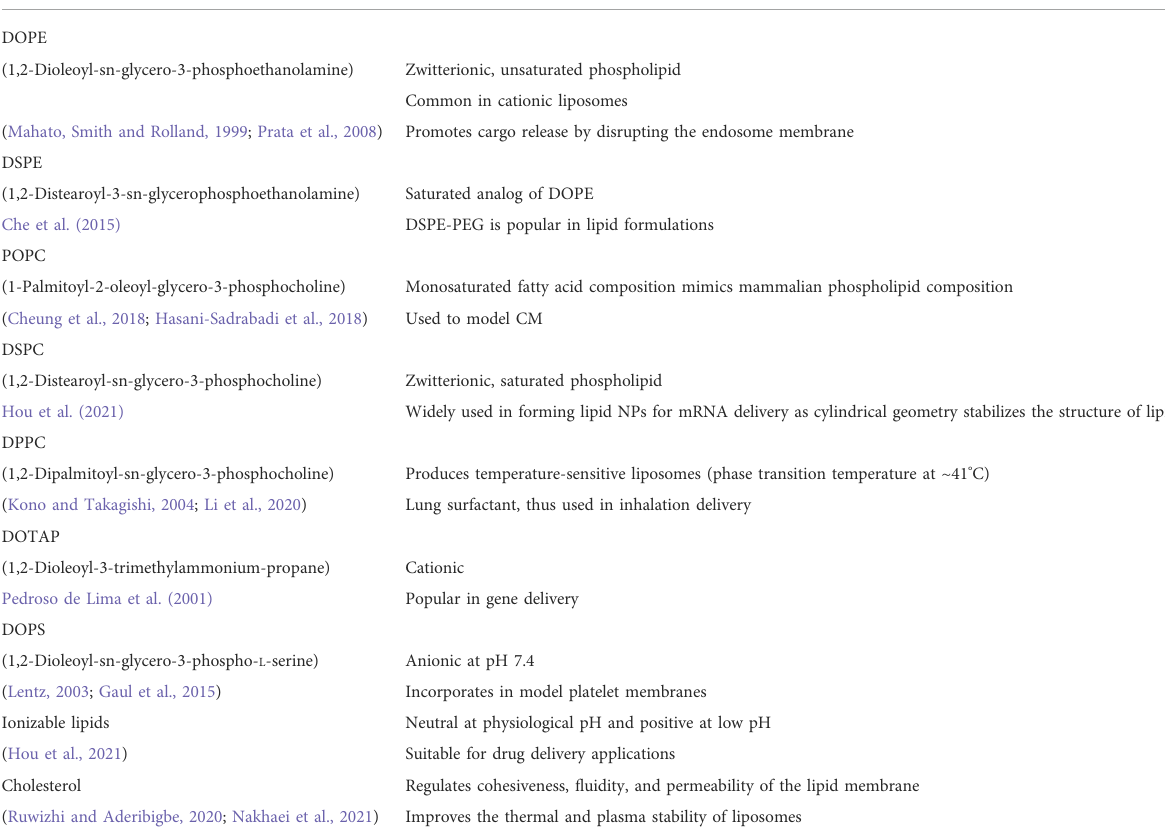
TABLE 4 Common lipid types, their characteristics, and uses.